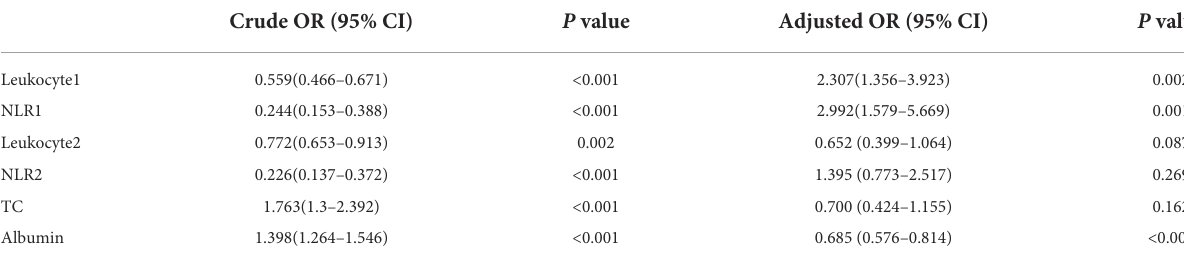
TABLE 3 Univariate and multivariate logistic analyses of parameters associated with acute epileptic seizure in patients with epilepsy.